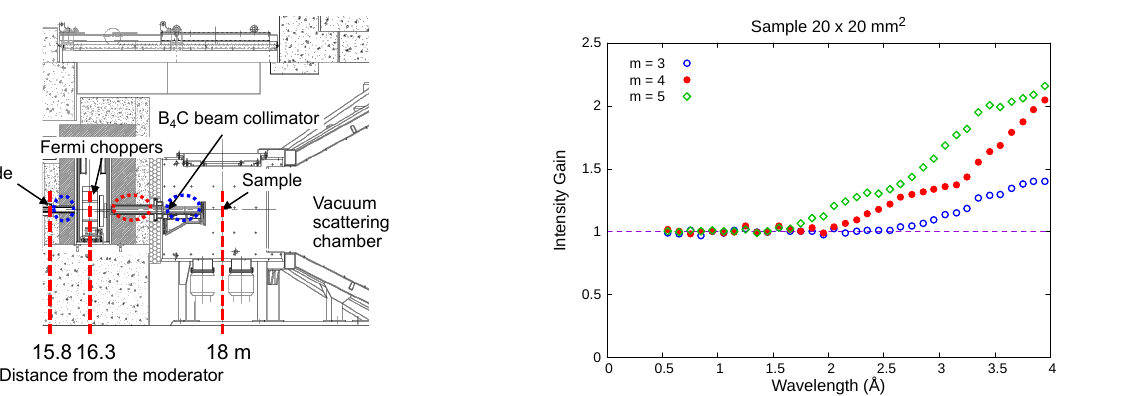
Figure 8. Gain in flux at a 20mm × 20mm sample by replacing the 50mm × 50mm × 580mm beam collimator after the Fermi chopper with a supermirror neutron guide obtained by Monte Carlo simulation. Open circles, closed circles, and open dia- monds show the gains when the m values of the supermirror are 3, 4, and 5,